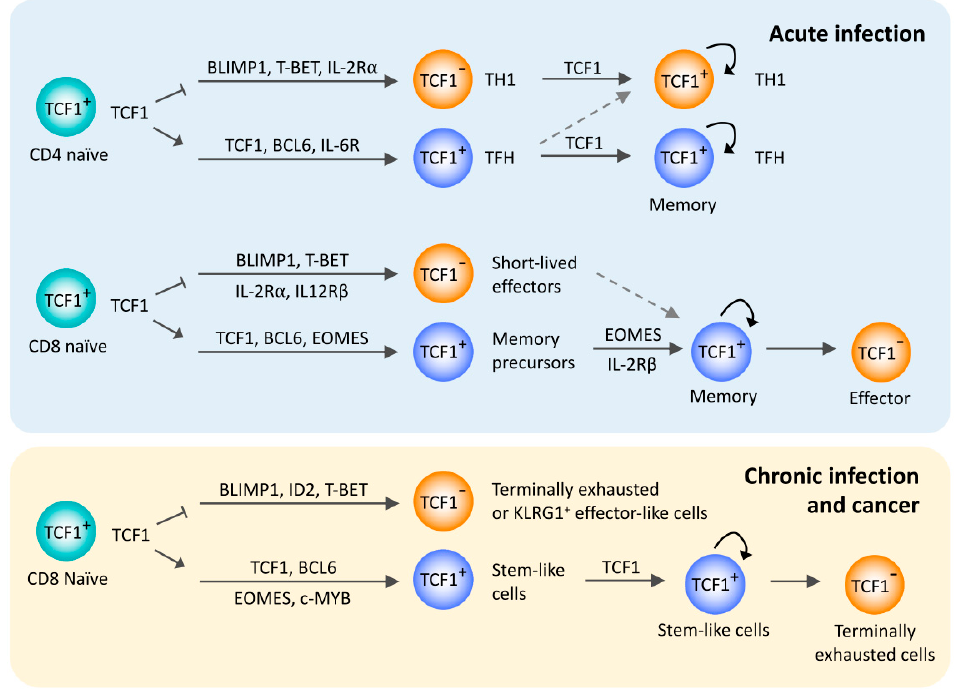
Figure 1. TCF1 in peripheral T cell responses to acute and chronic antigen stimulation. Overview of the regulatory functions of TCF1 in the di ff erentiation of T follicular helper cells and memory T